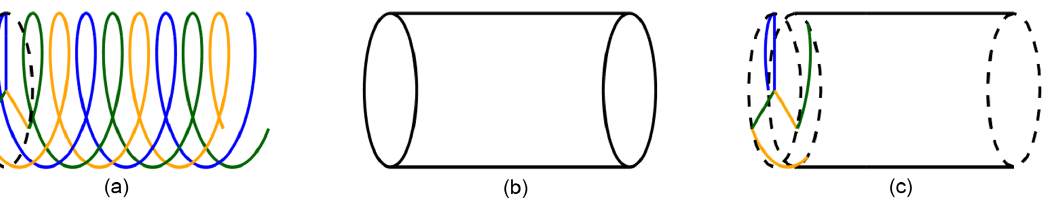
Figure 1. Illustration of the modeling of the blade and the wake in the three different engineering aerodynamic models. In the lifting-line method (a) , each blade is modeled by a bound vortex line, and the trailed vorticity is modeled with helical vortex filaments. In the generalized actuator disc model, such as the BEM method (b) , the blades are modeled by superposition of actuator discs with the aid of a tip correction model. The vortices are trailed from the rotor plane and form concentric cylindrical vortex wakes. Only the tip vortex is shown in the figure. In the coupled near- and far-wake model (c) , the blades and the near wake are modeled similar to the lifting-line method while the far wake is modeled similar to the BEM method.